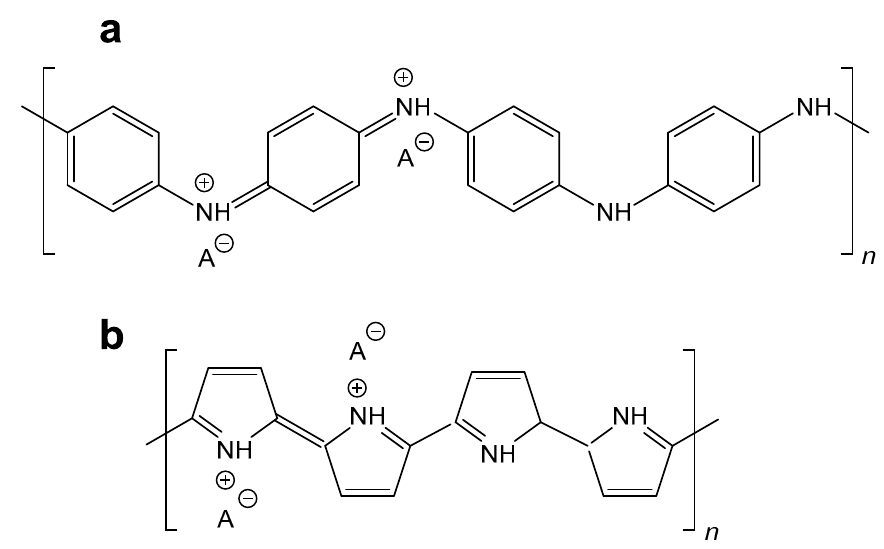
Figure 1. Conducting ( a ) polyaniline and ( b ) polypyrrole salts. A − is an arbitrary anion.